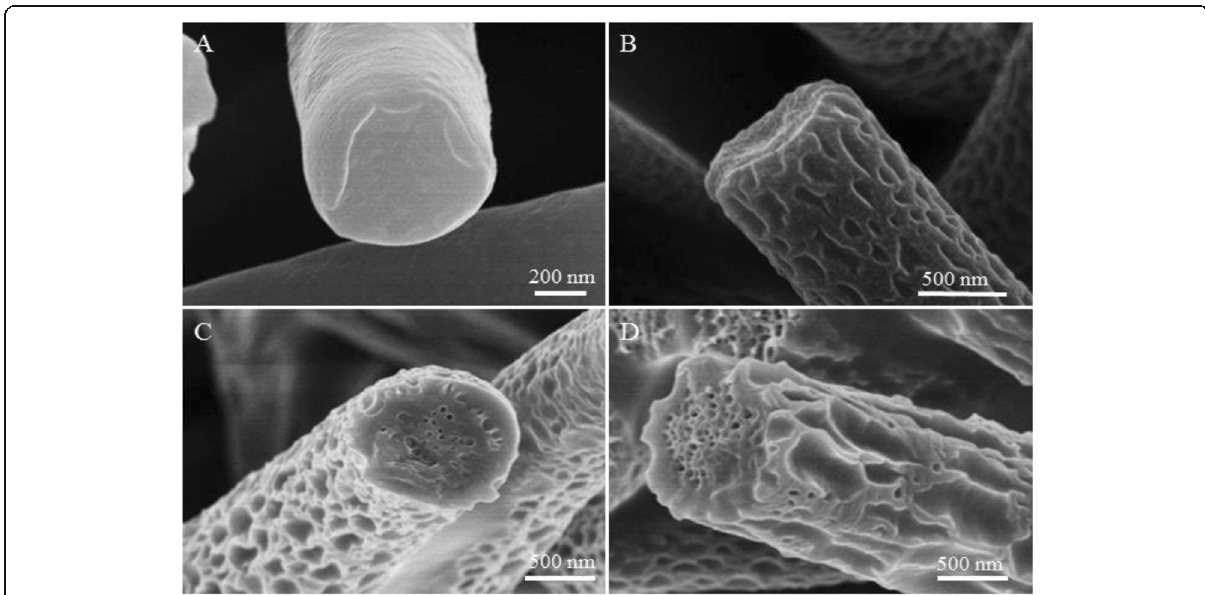
Fig. 2 Cross-sectional SEM images of samples fabricated by electrospinning 15% ( w / v ) PVDF solution from ACE at different levels of relative humidity. a 5%, b 25%, c 45%, and d 65%